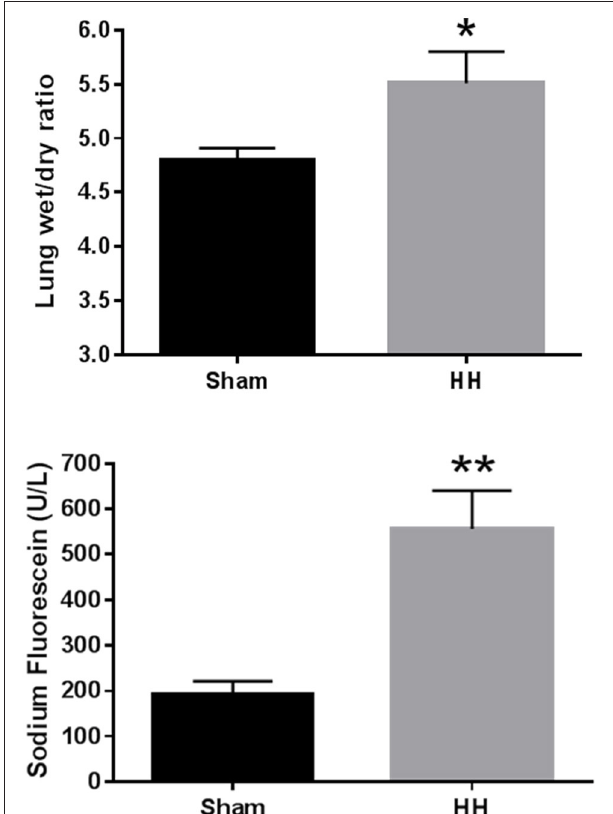
FIGURE 2 | Effects of HH on pulmonary fluid accumulation ( A , top) and pulmonary vascular permeability ( B , bottom). Animals were exposed to atmospheric pressure equivalent to 25,000 ft elevation or ambient pressure for 24h. * P < 0.05, ** P < 0.001. N = 8 per group.